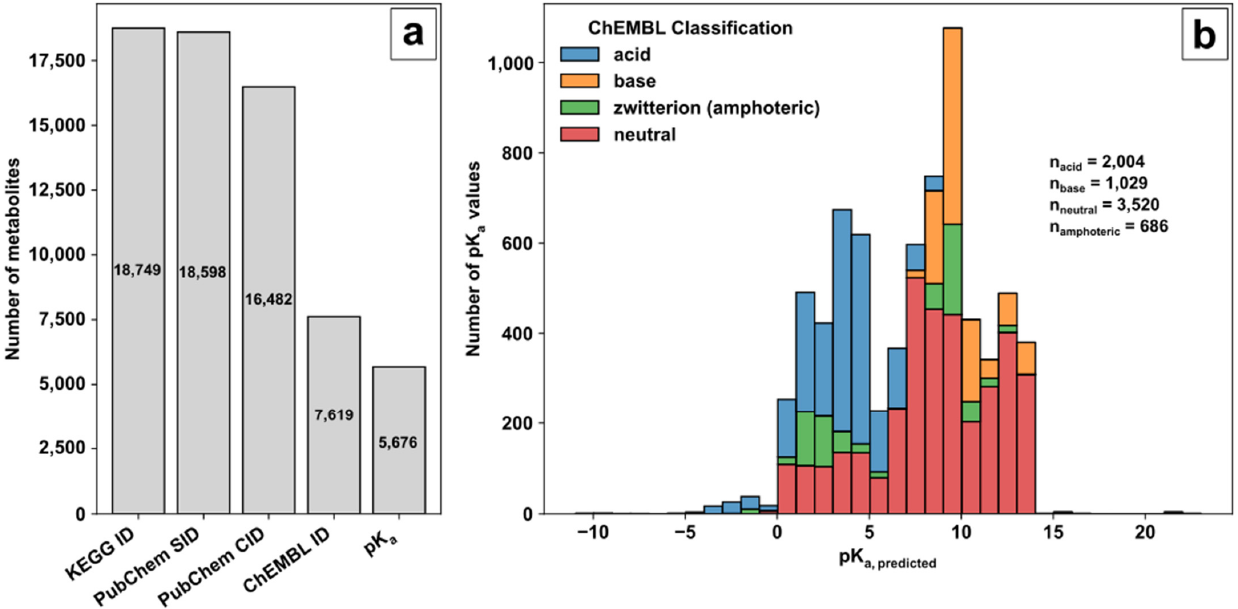
Figure 1. Database creation: ( a ) Filtering steps to acquire valid metabolite information for method development based on KEGG, PubChem and ChEMBL; ( b ) Histogram of pKa values with ChEMBL classifier for molecular species.